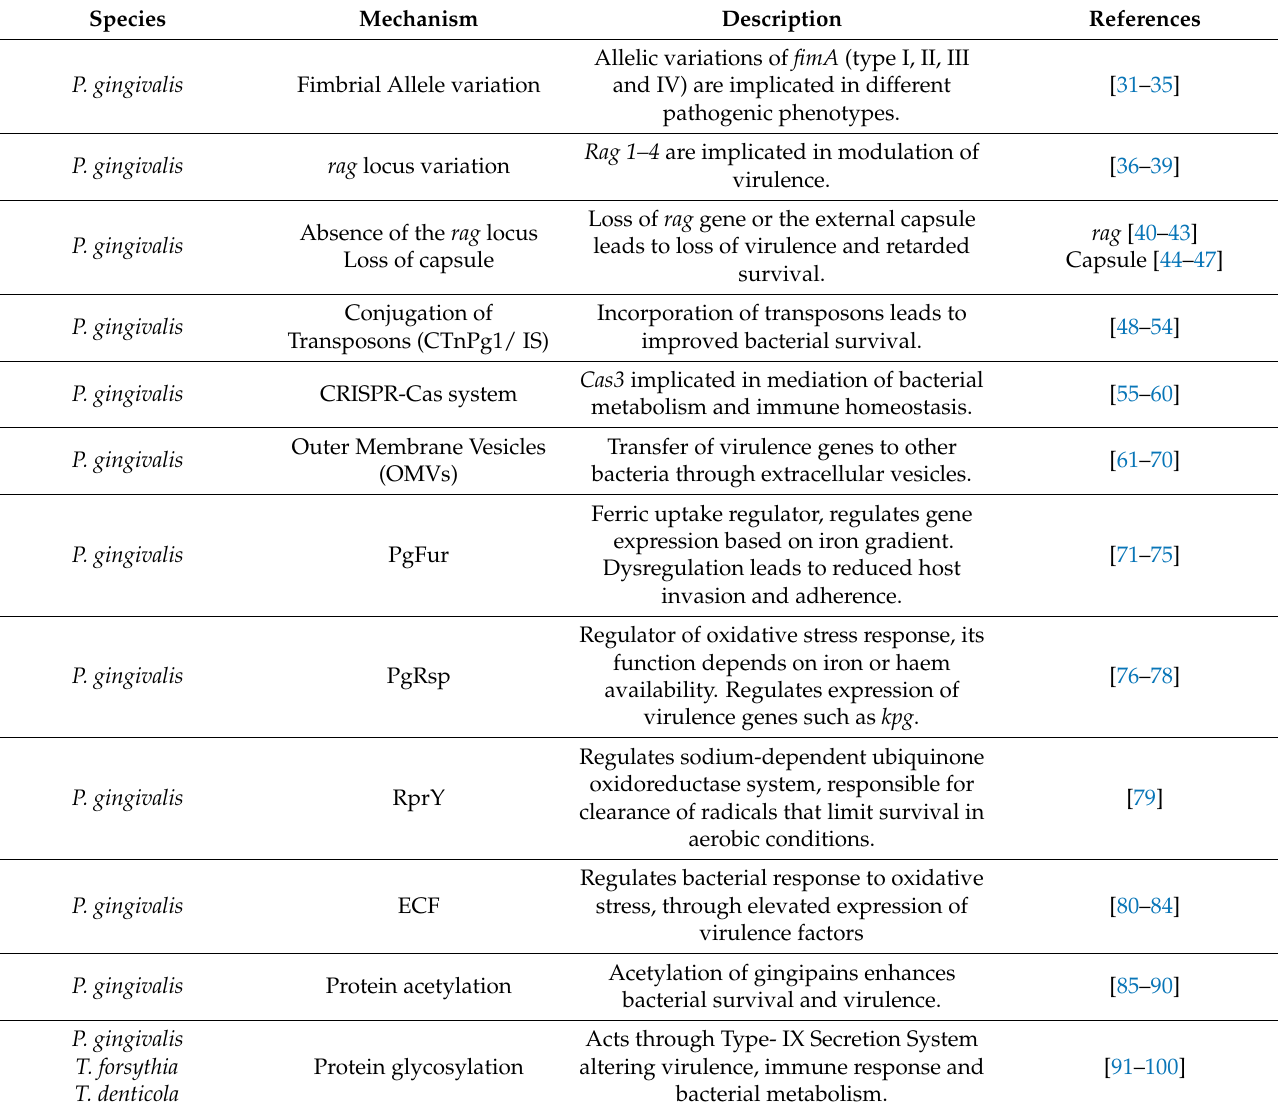
Table 1. Summary of modulatory mechanisms of pathogenicity employed by P. gingivalis and other periodontal pathobionts referenced in this